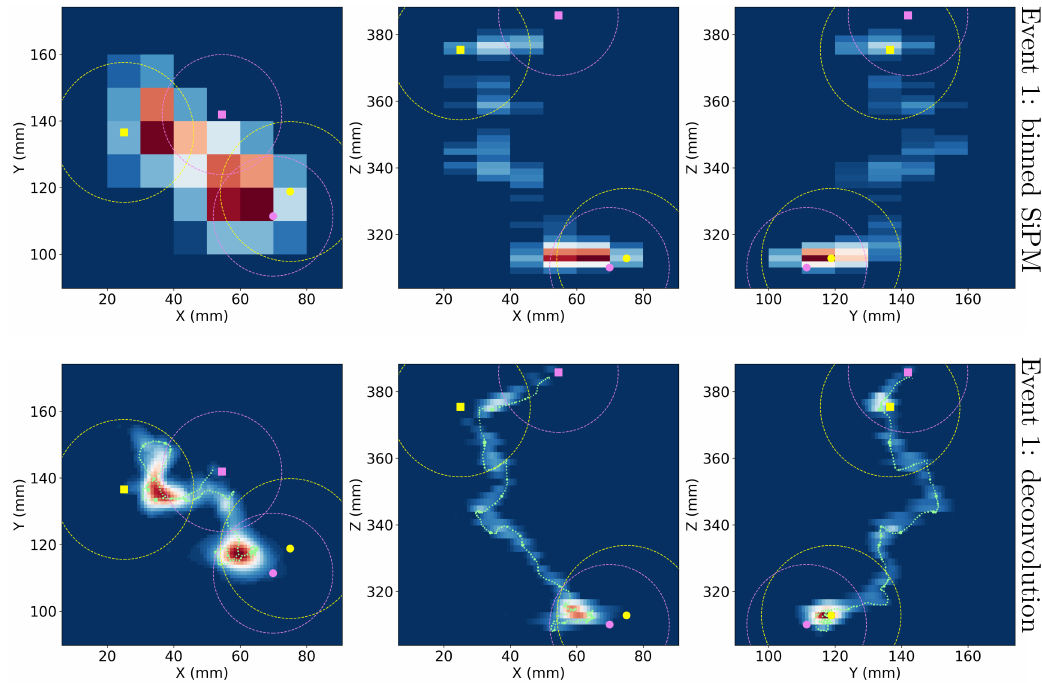
Figure 23 . An additional background event misidentified as signal by the classical analysis and correctly identified as background by the RL process. Symbols have the same meaning as in figure 22. Here the mistaken classification results from the high charge cut used in the classical analysis which removes ∼ 2 cm of the start of the